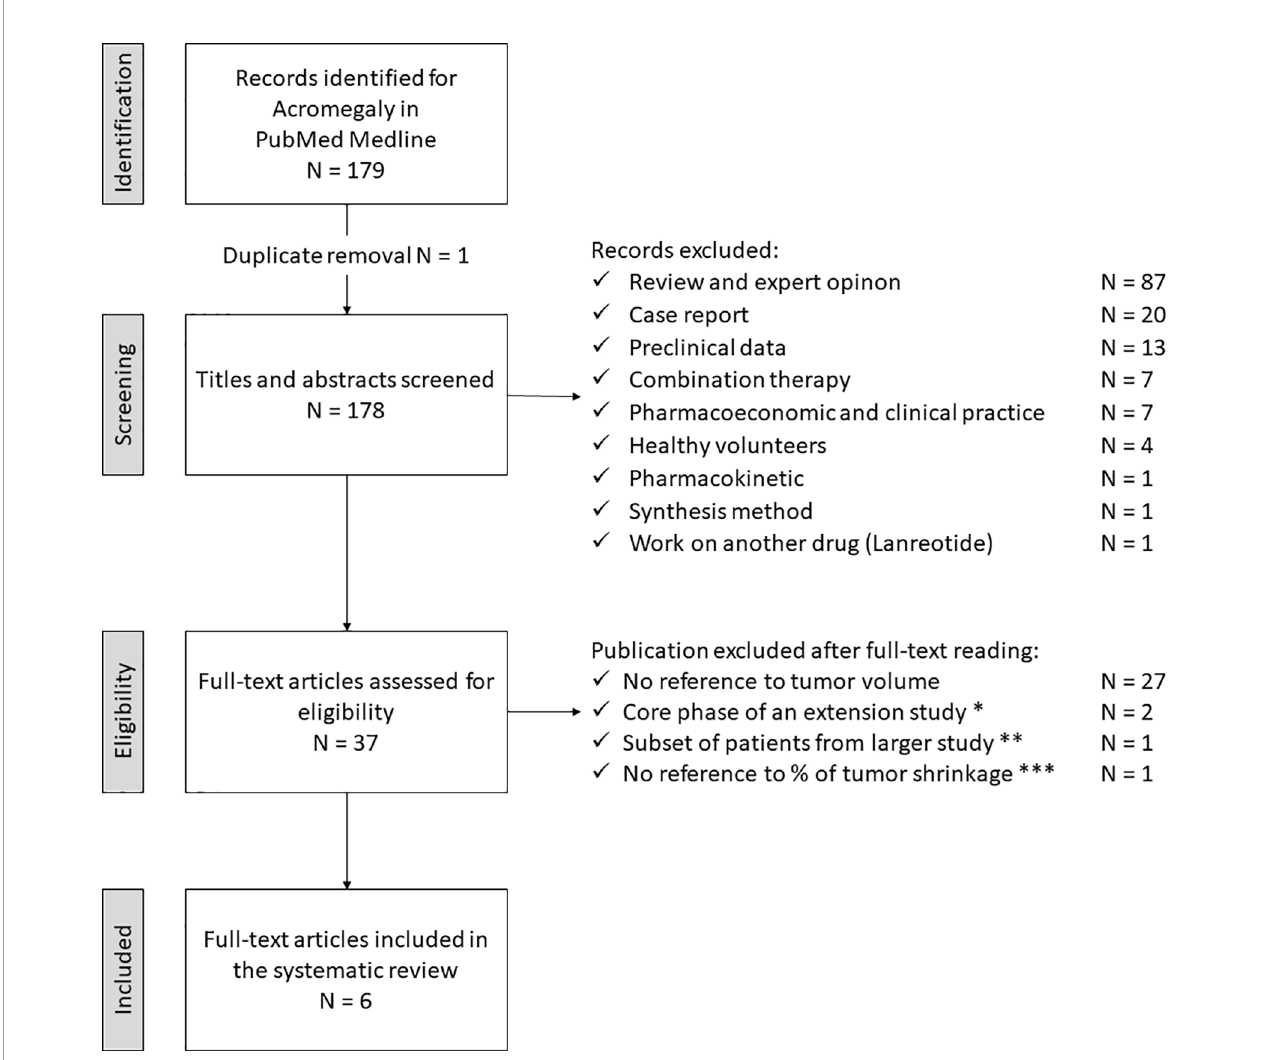
FIGURE 2 | Search strategy for acromegaly. * Petersenn S, 2010 (PAS sc, phase II) and Colao A, 2014 (PAS LAR). ** Shimon I, 2015 (PAS LAR). *** Tahara S, 2019 (PAS LAR, phase II). PAS, pasireotide, sc, subcutaneous, LAR, long-acting